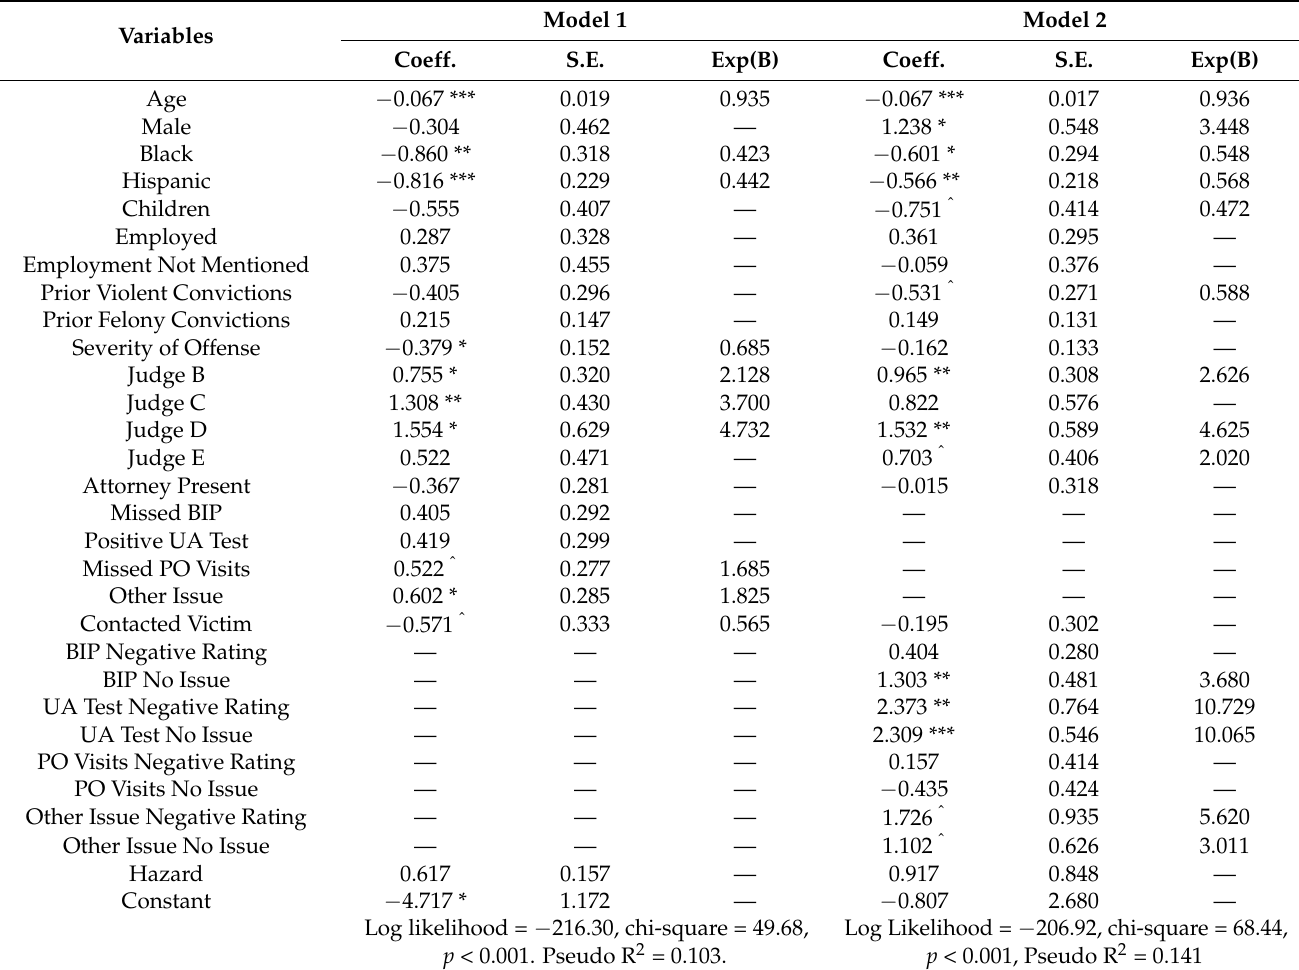
Table 3. Zero-Truncated Negative Binomial Regression Results Predicting the Length of a Jail Sanction ( n =